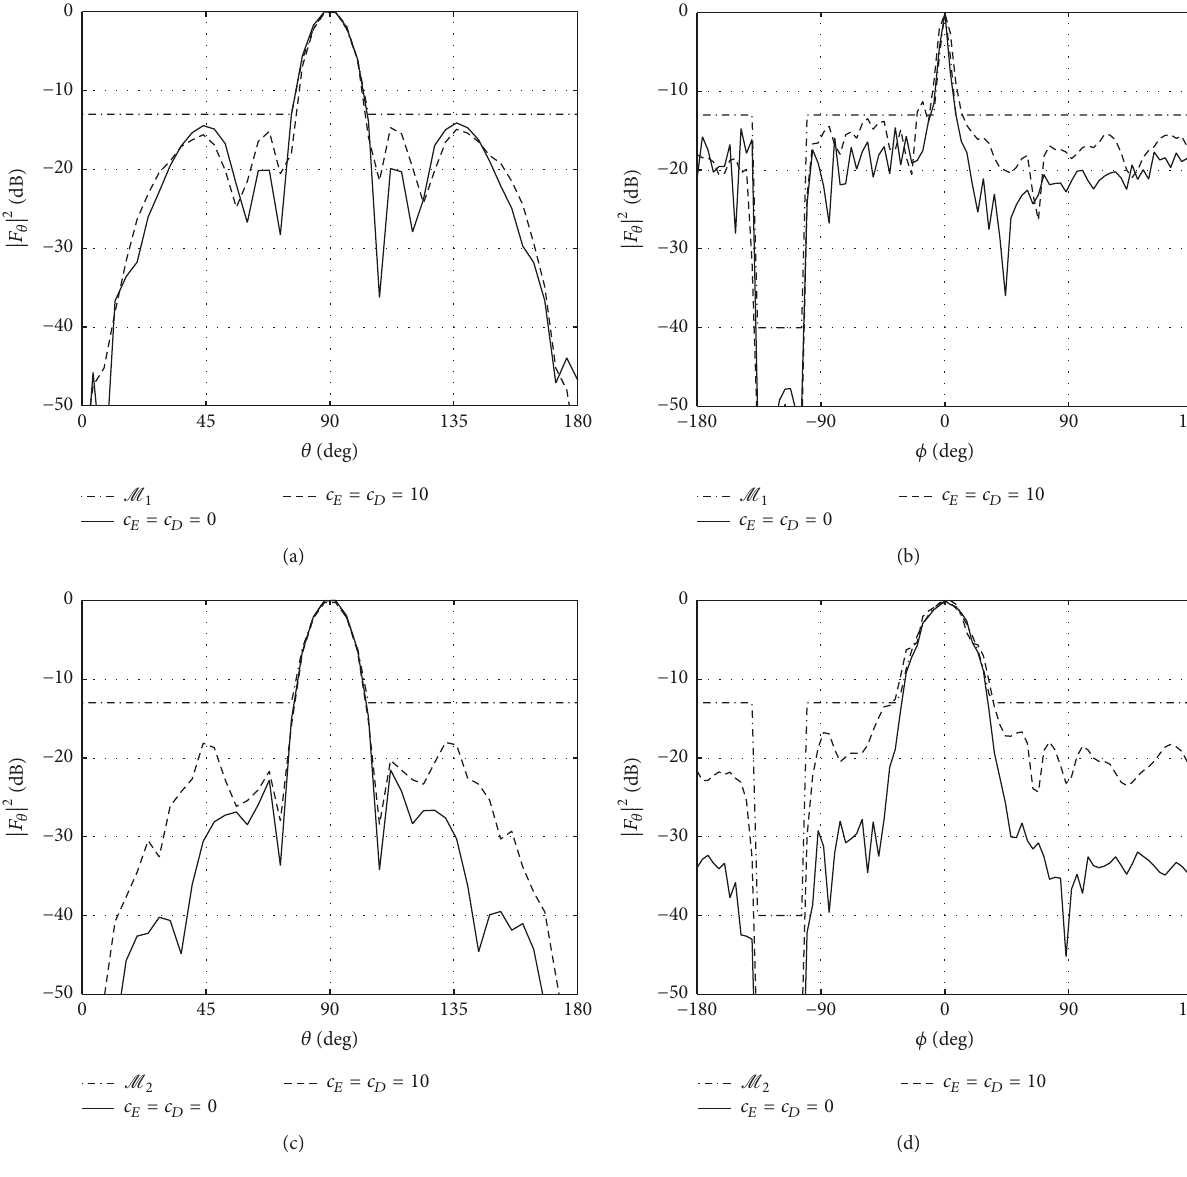
the calculations carried out at each iteration. The